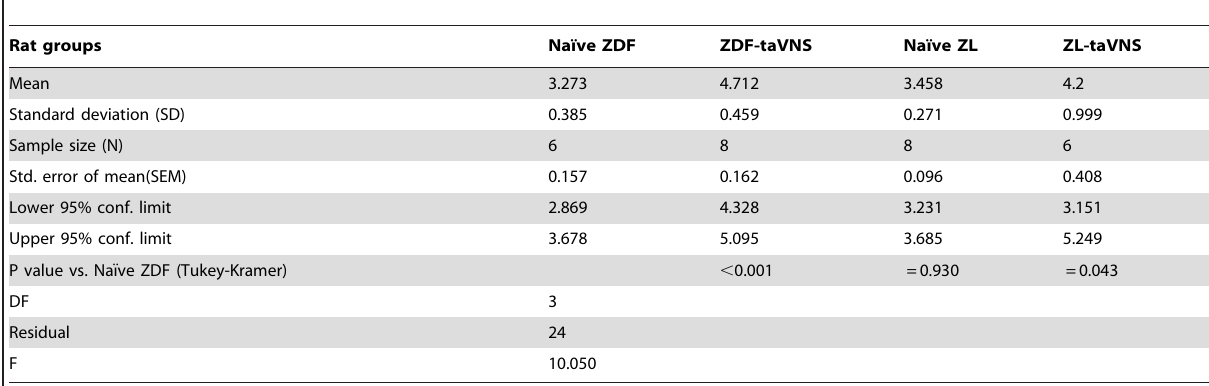
Table 1. Plasma melatonin concentration in rats on day